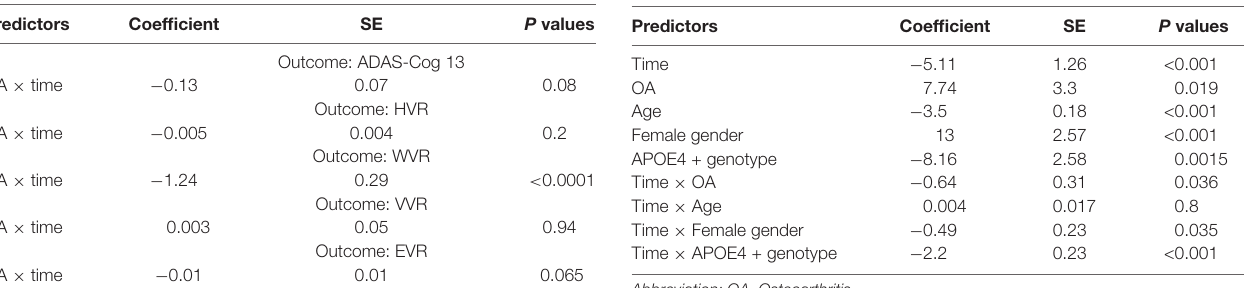
TABLE 3 | Association of OA status with change in WVR over time among non-demented older people with the duration of follow up (cid:53) 4